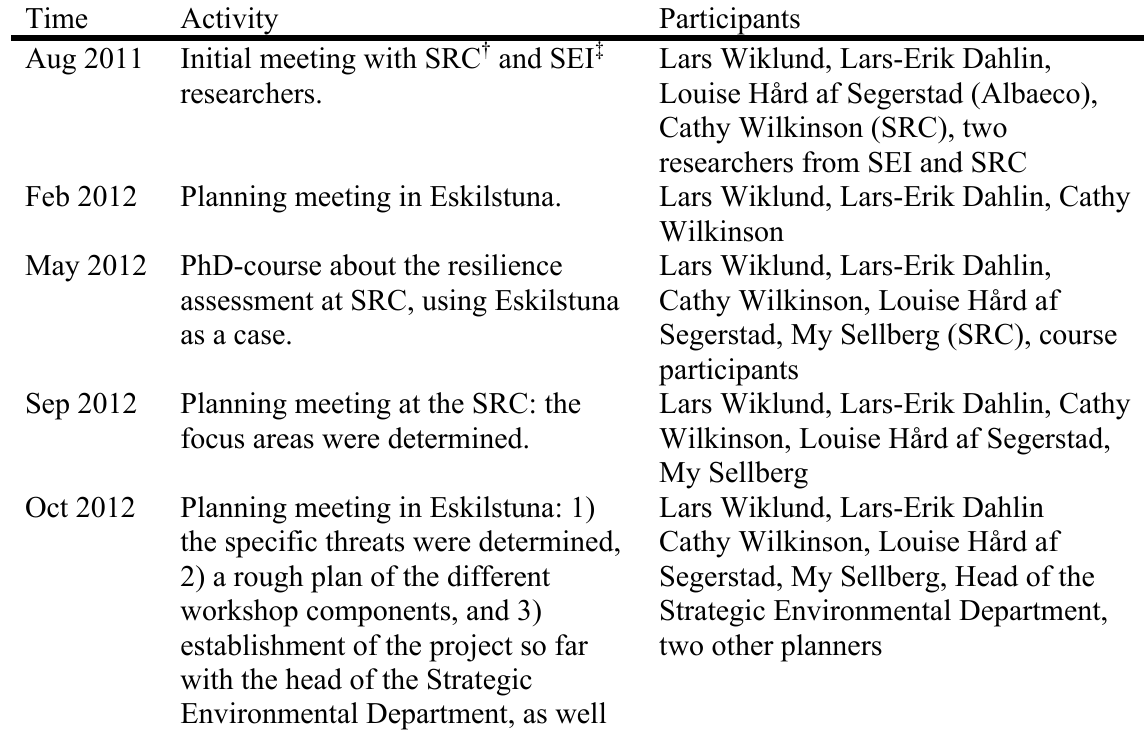
Table A2.1 . Activities and participants of the Eskilstuna’s initial resilience assessment Time